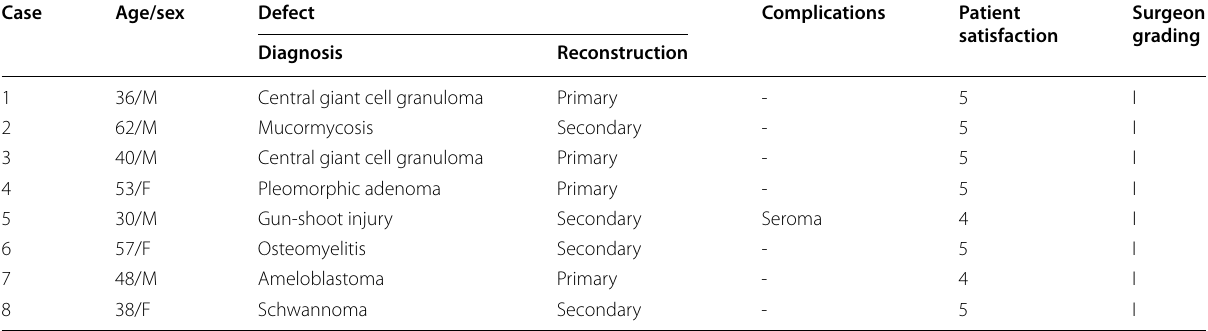
Table 1 Baseline data and outcomes for individual cases